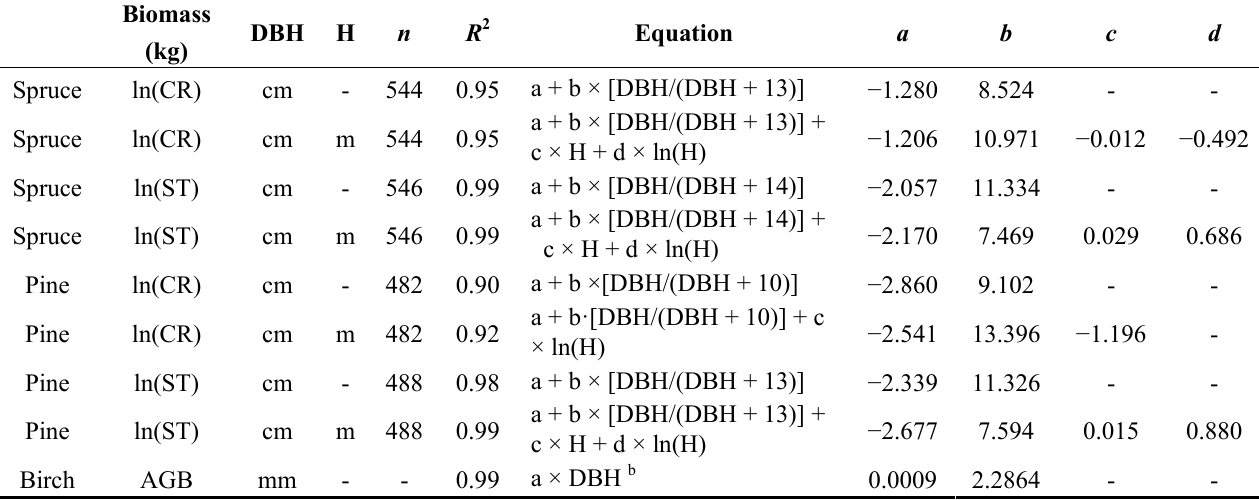
Table 1. Biomass equations for tree species in Sweden. Number of sampled trees ( n ), coefficients of determination ( R 2 ), diameter at breast height (DBH), height (H) of sampled trees and a, b, c, d are model parameters